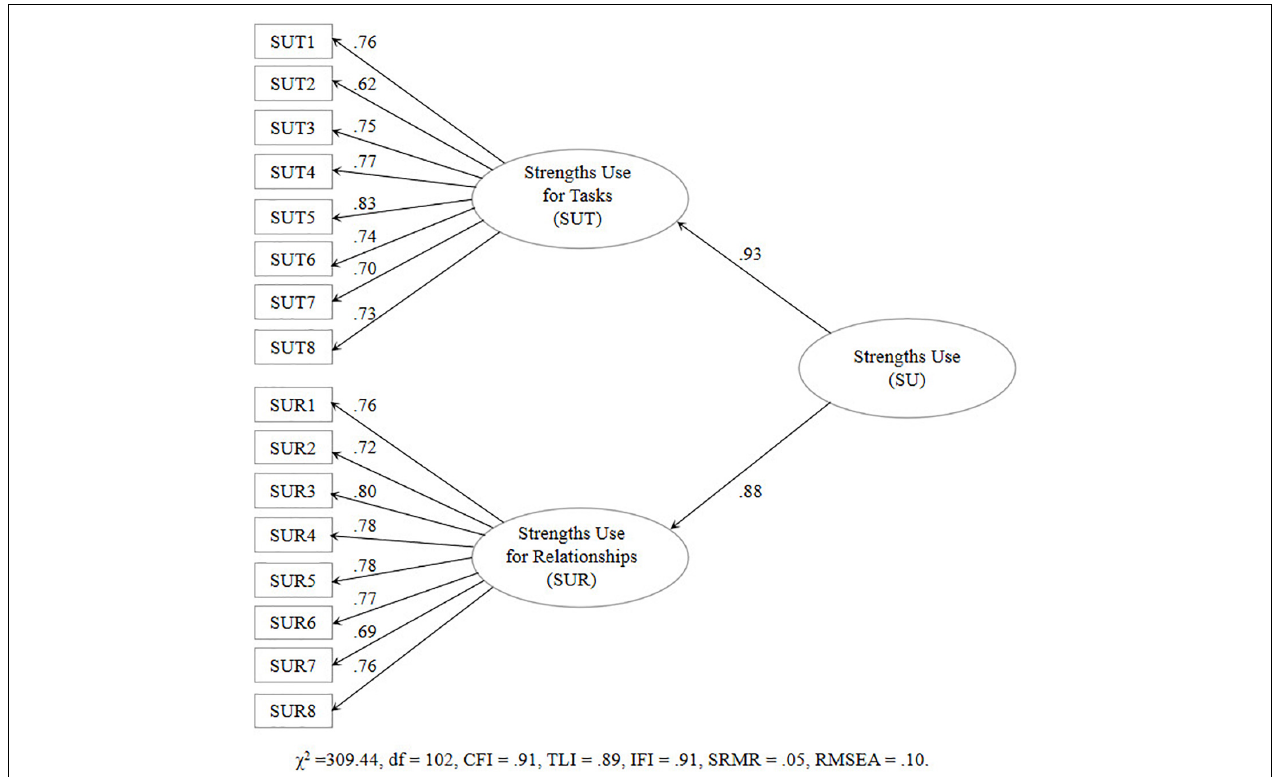
FIGURE 1 | Hierarchical second-order factor model of strengths